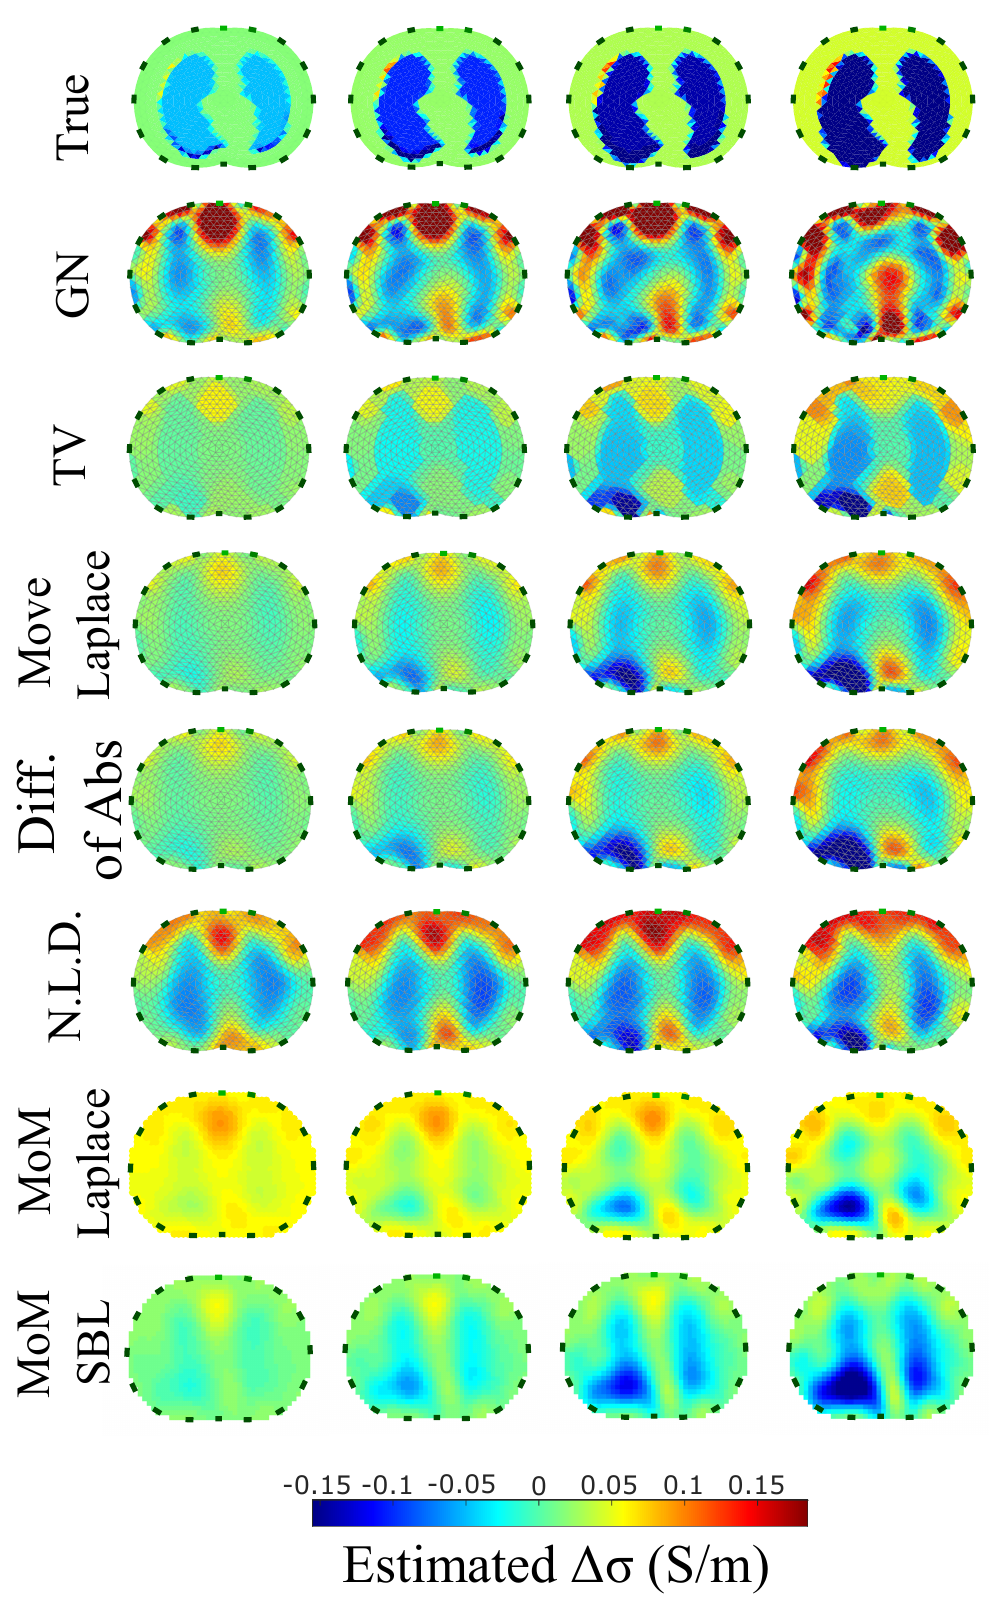
Figure 13. Reconstructed EIT images (conductivity differences) for the third